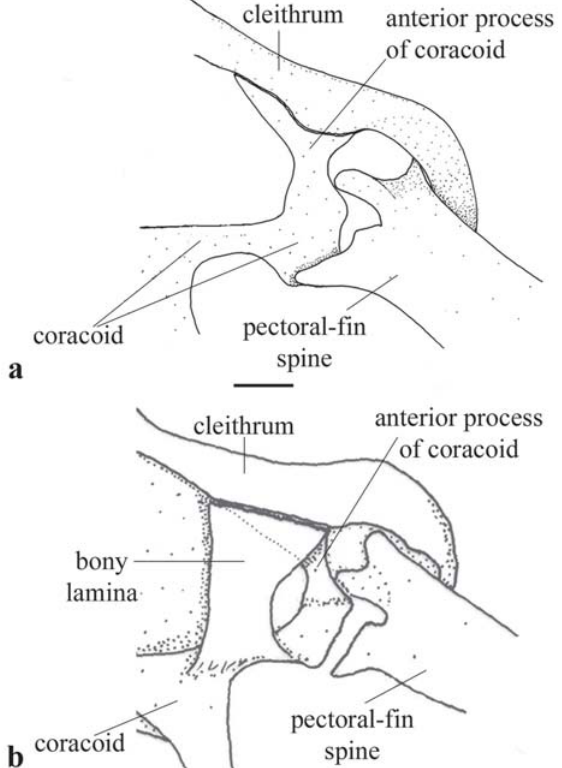
Fig. 48. Ventral view of ventrolateral portion of the pectoral girdle of Lamontichthys avacanoeiro (MZUSP 61974, 113.7 mm SL, paratype) (a), and L . filamentosus (LACM 41741-9, 119.4 mm SL) (b). Scale bar = 1 mm.